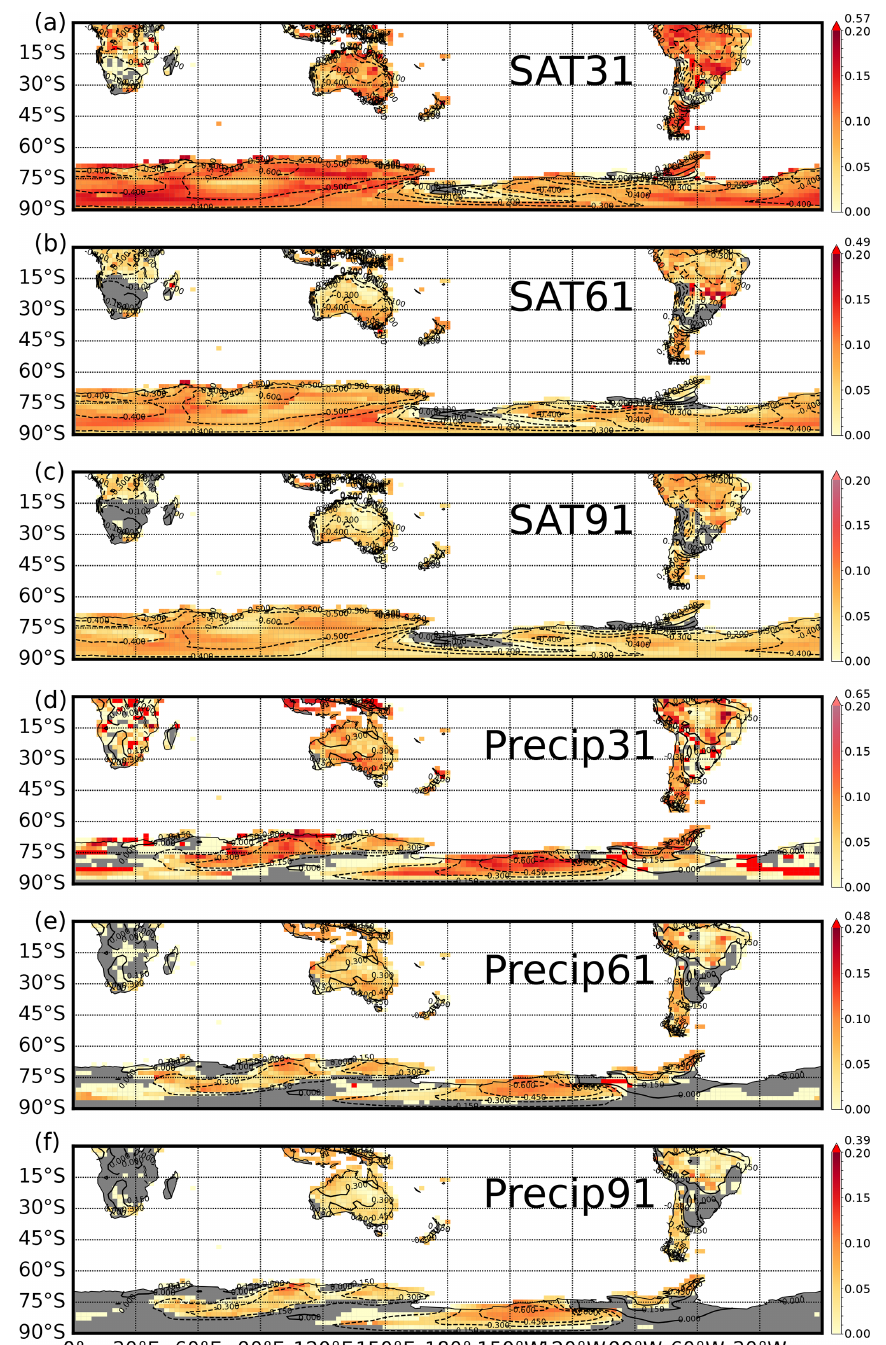
Figure 8. One standard deviation of the correlation of either the model SAT (a–c) or the precipitation (d–f) with the model SAM index over the 10 calibration windows. Panel (a) shows values for the ten 31 year calibration windows for SAT. Panels (b) and (c) show values for the ten 61 and 91 year windows, respectively. Panels (d) , (e) and (f) are the same, but for precipitation. Maximum values on the colour bars for panels (a) , (b) , (d) , (e) , and (f) indicate the colour of several outliers in the data. Grey regions indicate cells that did not meet the minimum correlation criteria ( r ≥ | 0 . 3 | ) over any windows, meaning that no standard deviation could be calculated. Dashed contours show the model SAM–SAT (a–c) and SAM–precipitation (d–f) 500 year correlation fields from Fig.